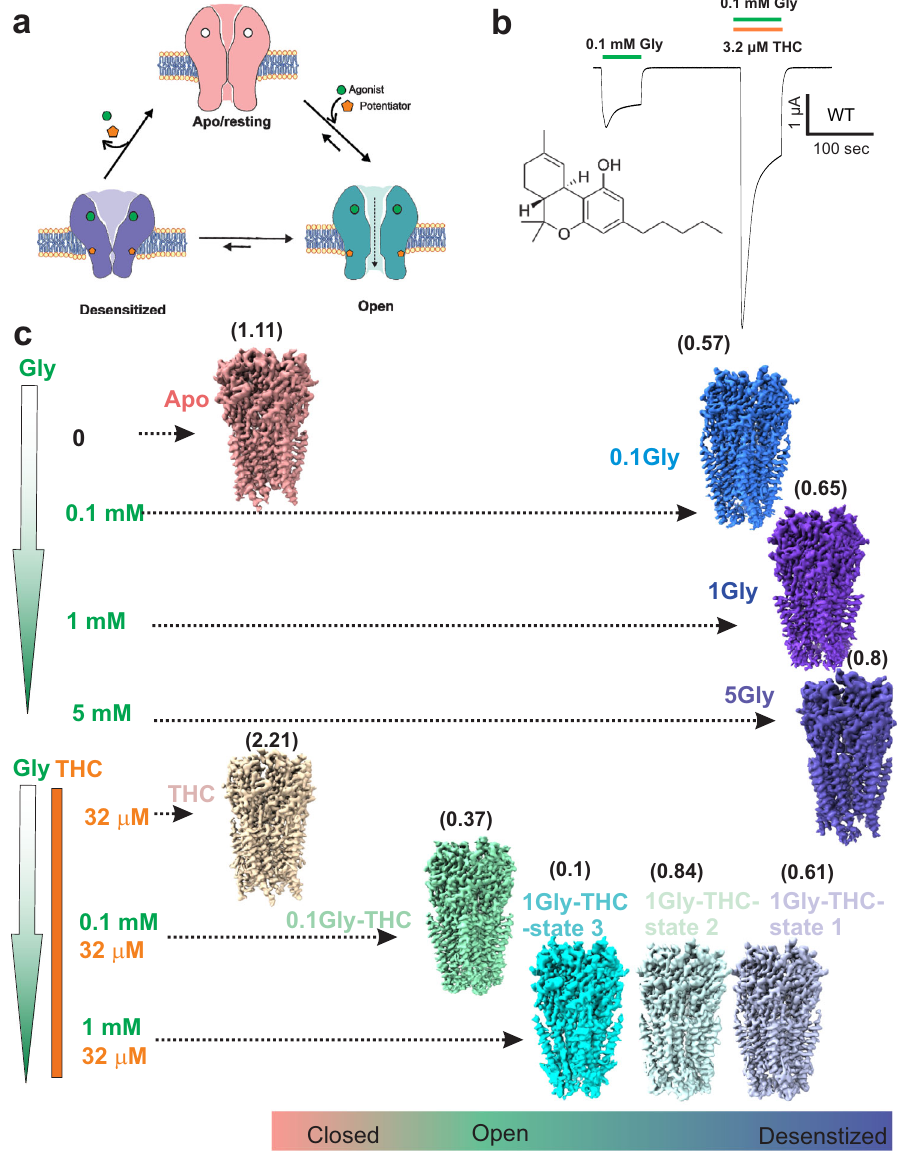
Fig. 1 | Cryo-EM analysis of GlyR gating and THC modulation. a Schematic representation of GlyR gating involving transitions from the Apo (resting) to glycine-bound, open and desensitized conformations. b TEVC recording of GlyR currents activated by 0.1mM glycine, and with co-application of 3.2 μ M Δ 9 -tetrahydrocannabinol (THC). Chemical structure of THC. c Cryo-EM 3D